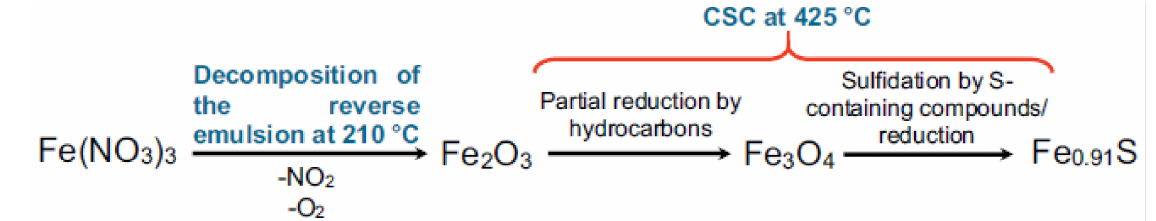
Figure 7. Transformation mechanism of iron nitrate during catalytic steam conditions [58,59].